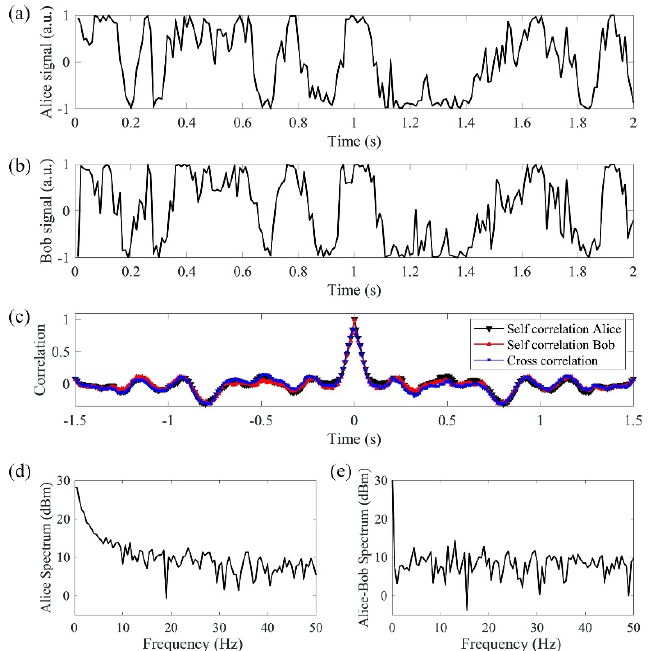
Figure 7. ( a ) and ( b ) are the received signals from Alice and Bob with high-frequency phase fluctuations filtered; ( c ) shows the self-correlations and cross-correlation of the signals; ( d ) Alice’s spectrum; ( e ) differential spectrum between Alice and Bob has a much smaller amplitude than Alice’s spectrum.